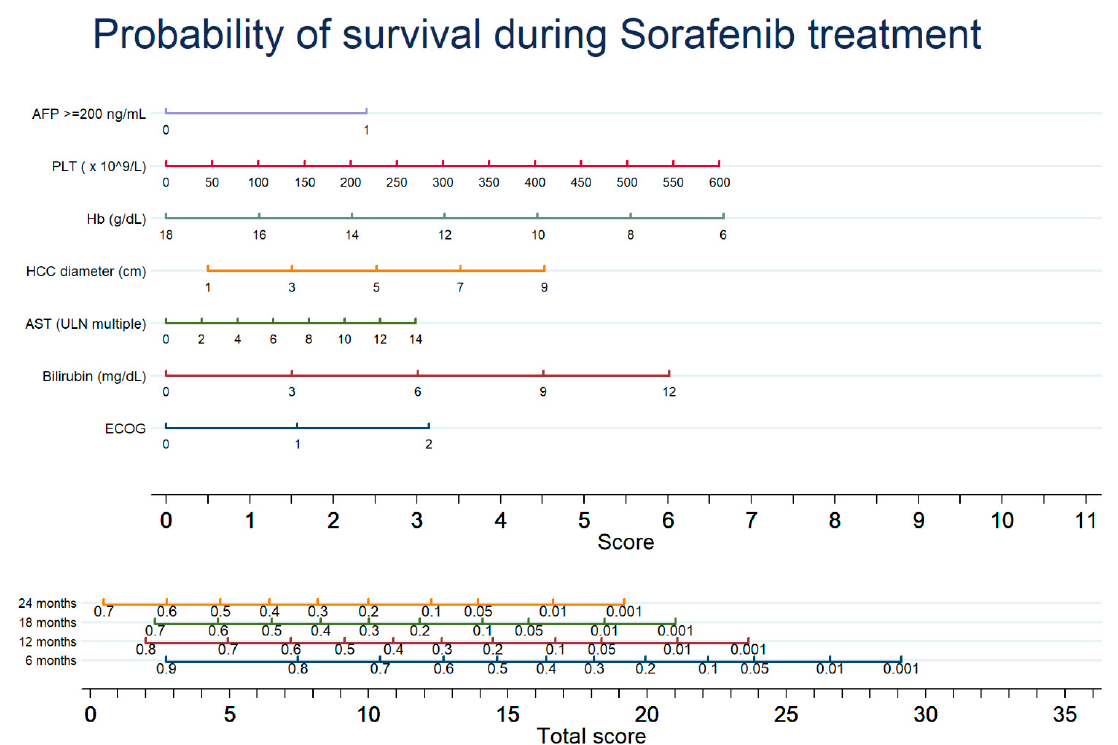
Figure 2. Nomogram for prediction of survival at 12, 24 and 36 months in patients with advanced HCC starting Sorafenib treatment. The effect of each variable on survival is obtained drawing a vertical line from variable’s line up to the “Score” line. The total score is obtained by adding the score for each variable. The probability of survival at each time point is obtained drawing a vertical line from “Total score” up to time point lines. Table 3. Predictors of HCC progression (expressed according to mRECIST criteria) with statistical significance at the uni- variate and multivariate analysis.